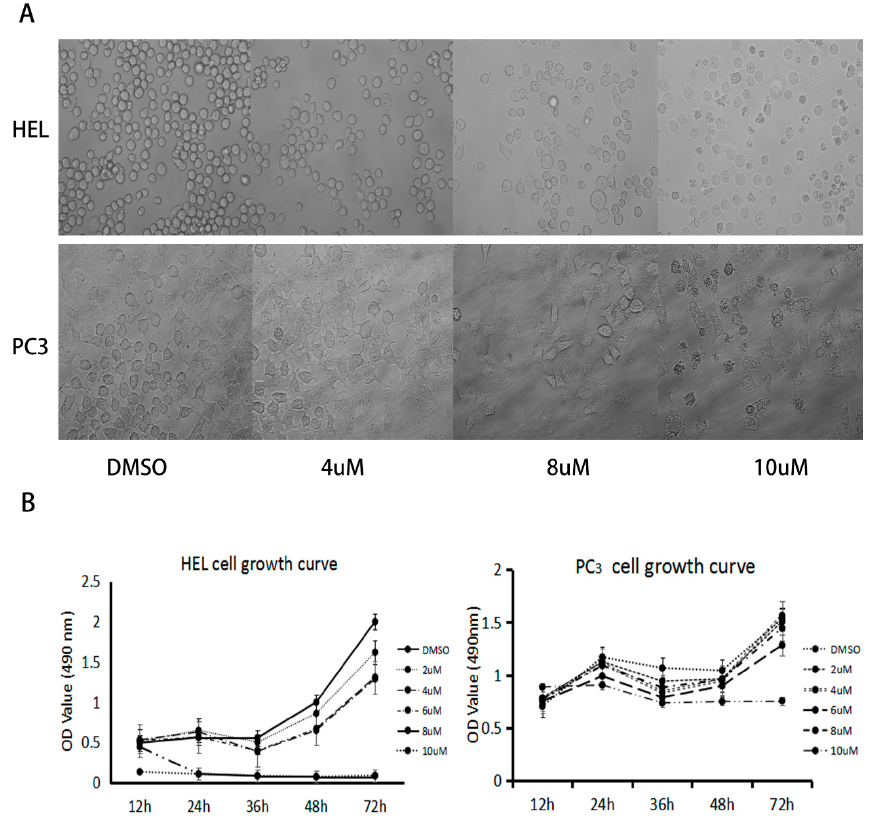
Figure 2. Inhibition effect of 6k on proliferation of HEL and PC3. ( A ) Morphological changes of HEL and PC3 cells at different concentrations of 6k after 24 h of drug treatment, and ( B ) cytotoxic effects of 6k on HEL and PC3 cell proliferation at the indicated times.